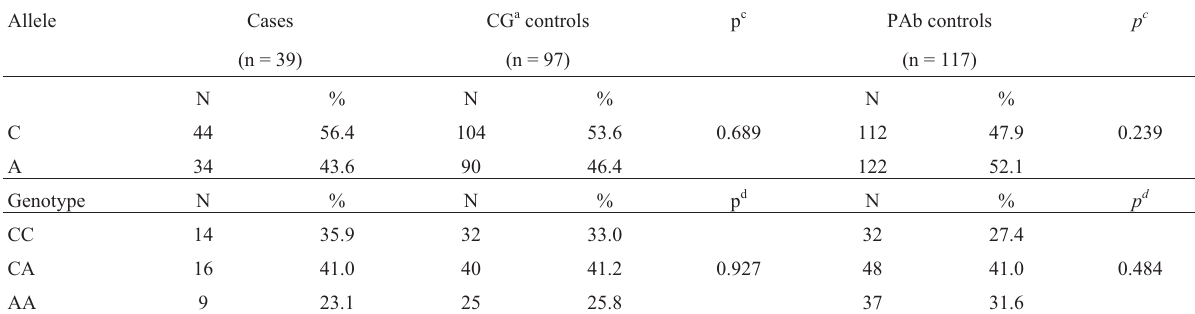
Table 2 - Frequency of IGFBP3 rs2854744 gene polymorphism in cases and controls.